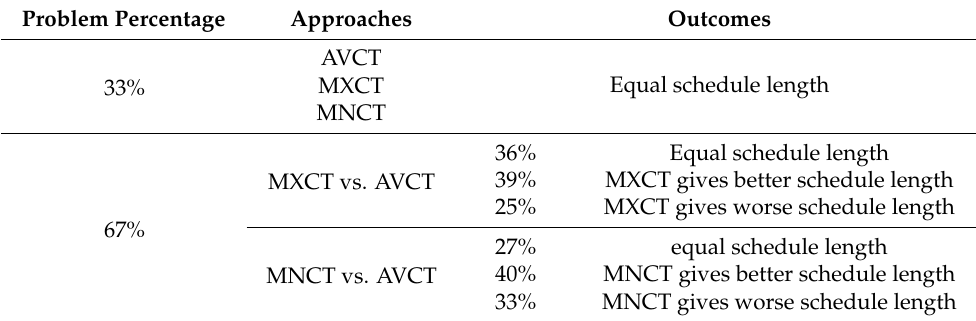
Figure 9. Variations in schedule length obtained from AVCT approach and MNCT approach. Table 3. Comparison of AVCT, MXCT, and MNCT algorithms.